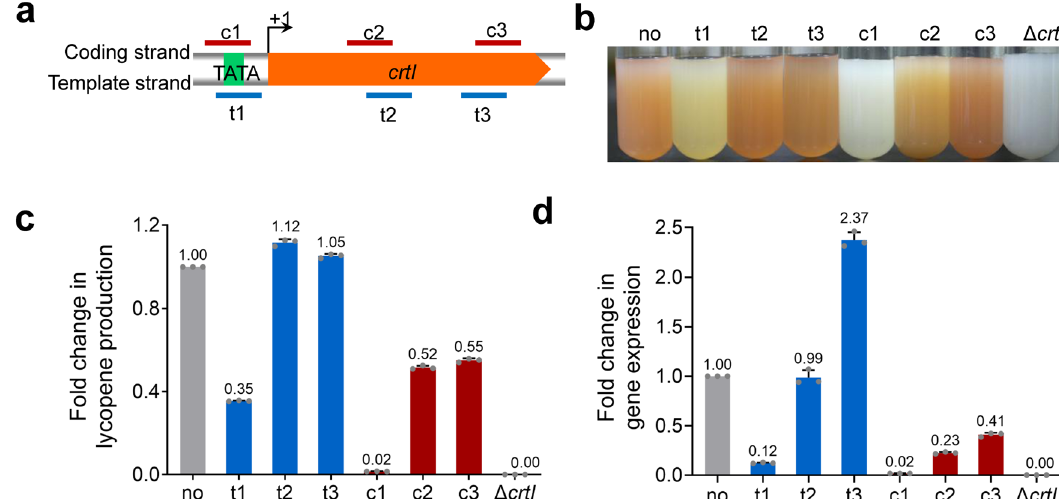
Fig. 3 Repression of crtI gene using CRISPRi. a Location of crRNA target sites in the crtI gene. crtI is transcribed from the A of the start codon ATG. The TSS is shown as + 1. t1, t2, and t3 are crRNAs targeting the template strand of crtI . c1, c2, and c3 are crRNAs targeting the coding strand of crtI . b Cell colors of 50B Δ 2549 Δ cas3 expressing different crRNAs targeting crtI . c Fold change in lycopene production of 50B Δ 2549 Δ cas3 expressing different crRNAs targeting crtI . d Fold change in the expression of crtI . In b , c , d no and Δ crtI represents the control strain with no crRNA expression and with crtI knockout, respectively. Data shown for three biological replicates. Error bars indicate SDs, n =